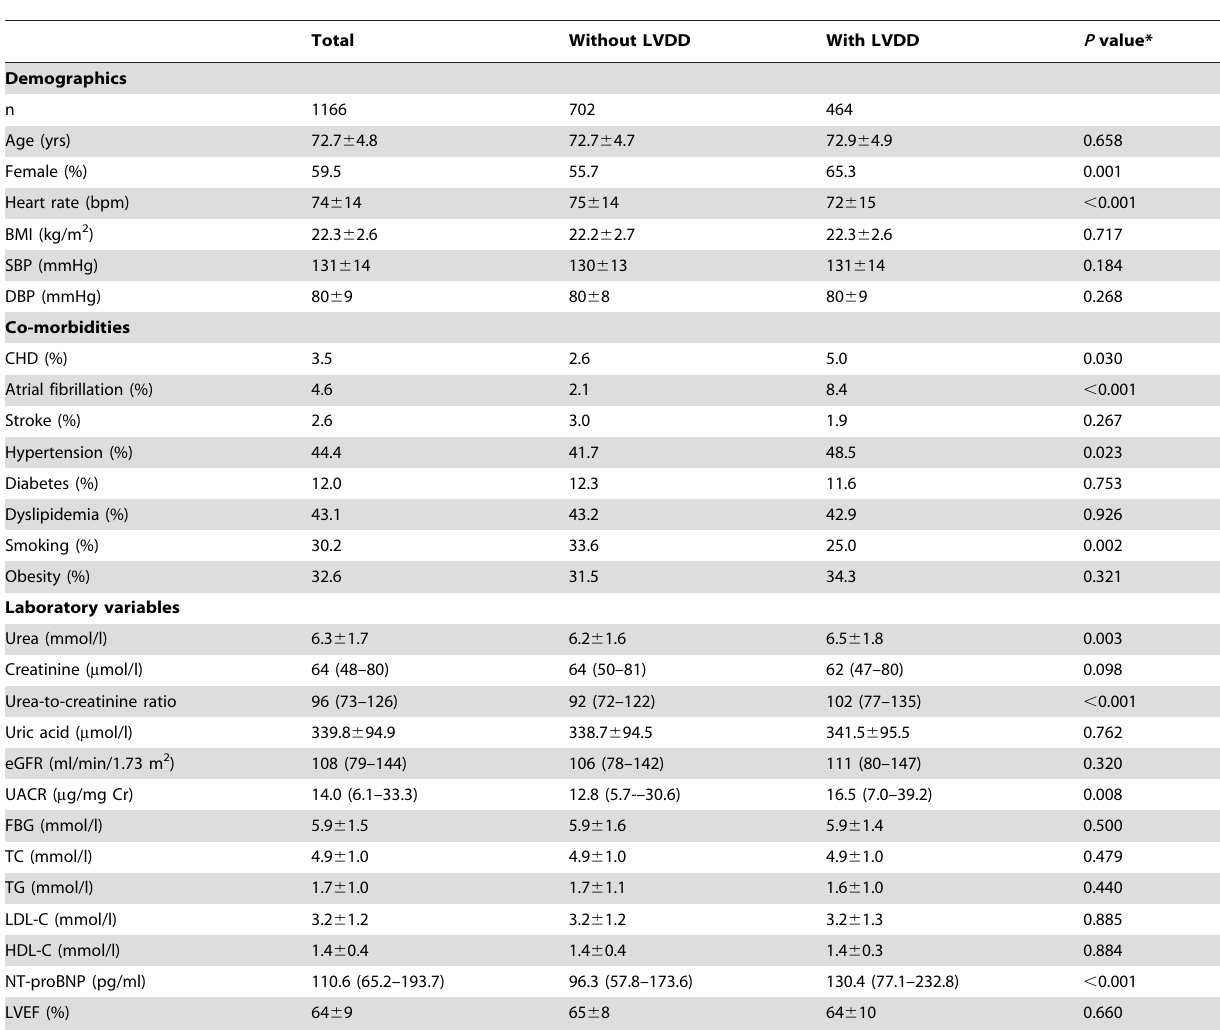
Table 1. Characteristics of participants according to presence and absence of